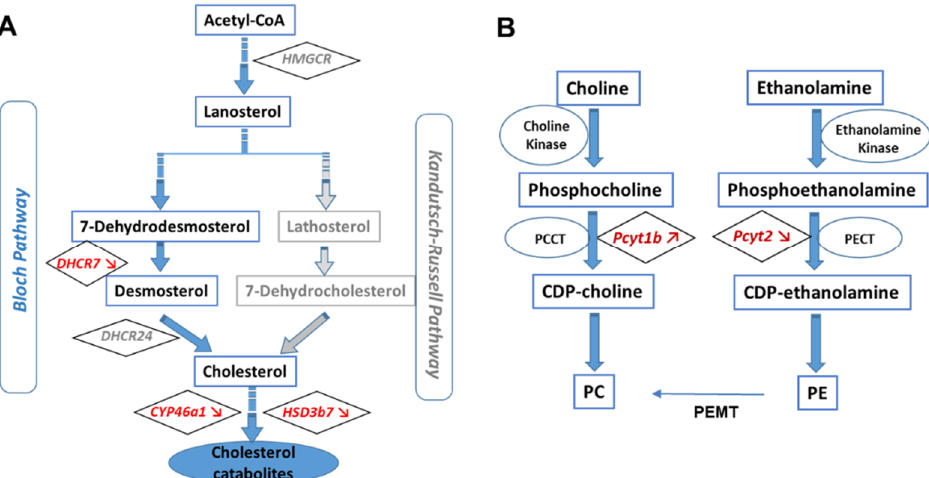
Figure 8. A: Pathway of cholesterol synthesis in the brain from acetylCoA reduction by HMGC re- ductase, through the action of 7-dehydrocholesterol reductase (DHCR7) and 3β-hydroxysterol 24- reductase (DHCR24); its catabolism involves the formation of various catabolites by the actions of several enzymes such as cytochrome P450 family 46 subfamily A member 1 (CYP46a1) and hydroxy- delta-5-steroid dehydrogenase, 3 beta- and steroid delta-isomerase 7 (HSD3b7); B : Pathway of PC and PE synthesis [66]. Abbreviations: PCCT—phosphocholine cytidylyltransferase, encoded by Pcyt1b; PECT—phosphoethanolamine cytidylyltransferase, encoded by Pcyt2; CDP-choline—cyti- dil-5-diphosphocholine; CDP-ethanolamine—cytidil-5-diphosphoethanolamine; PC—phosphati- dylcholine; PE—phosphatirylethanolamine; PEMT—phosphatidylethanolamine N -methyltrans- ferase.